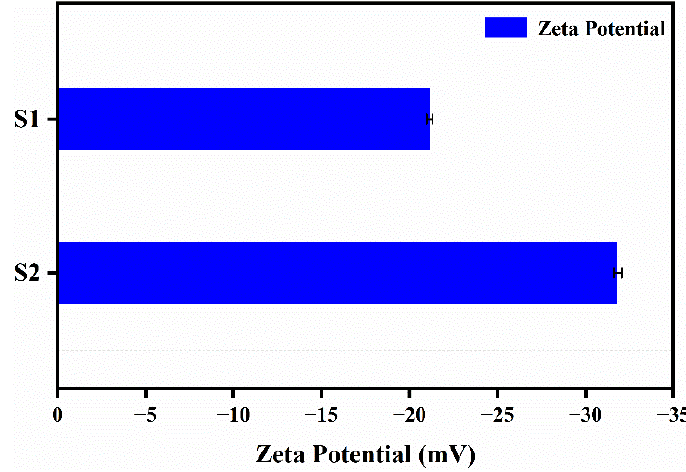
Figure 7. Zeta potential of nanocapsules (S1 and S2) with pure water as an antisolvent for S1 and an antisolvent of an aqueous PVA solution for S2.